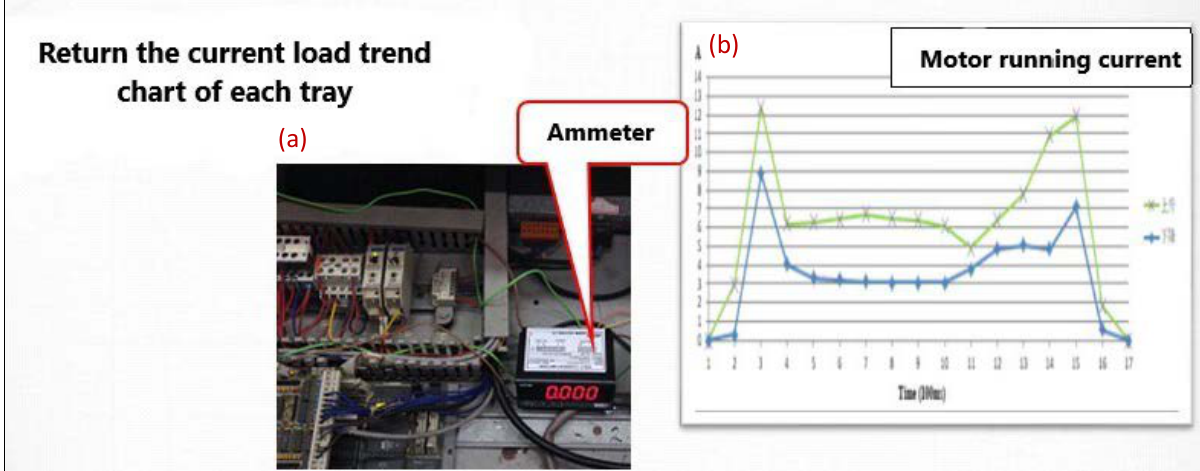
Figure 4. (a) Setup a current sensor on the motor of vertical lift (left). (b) Current plot